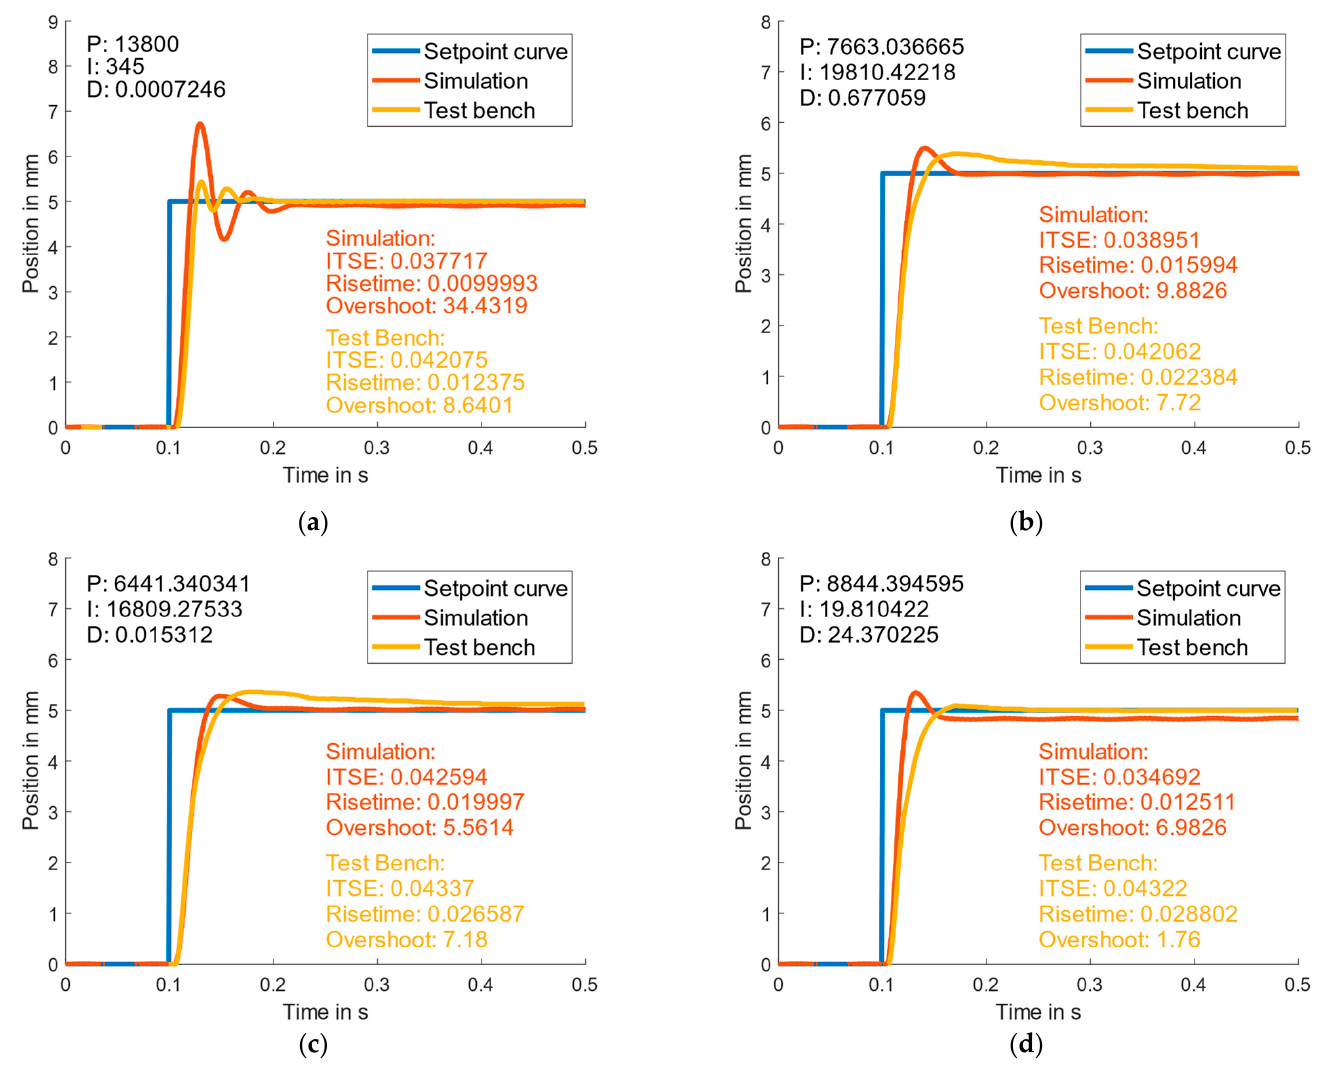
Figure 8. Comparison of the simulated and on the test bench measured step response of the EHA with the following PID parameters obtained with the method for multi-objective optimization of PID control for the spring load: ( a ) Ziegler Nichols characterization [ K P = 13,800; K I = 345; K D = 0.0007246], ( b ) system characterization [ K P = 7663.036665; K I = 19,810.42218; K D = 0.677059], ( c ) first optimization loop [ K P = 8844.394595; K I = 19.810422; K D = 24.370225], and ( d ) second optimization loop [ K P = 6441.340341; K I = 16,809.27533; K D =